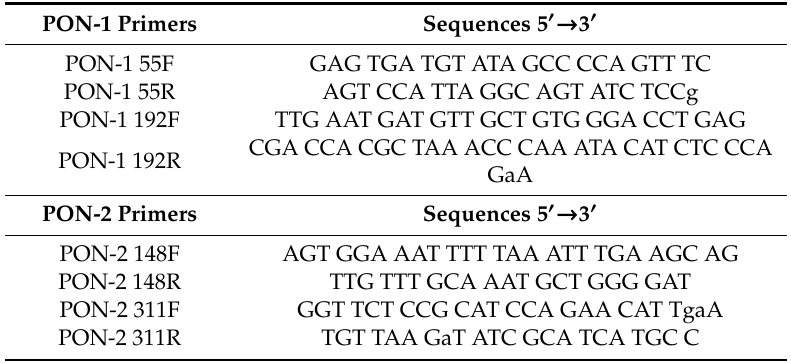
Table 1. Sequences of primers to determine PON1 and PON2